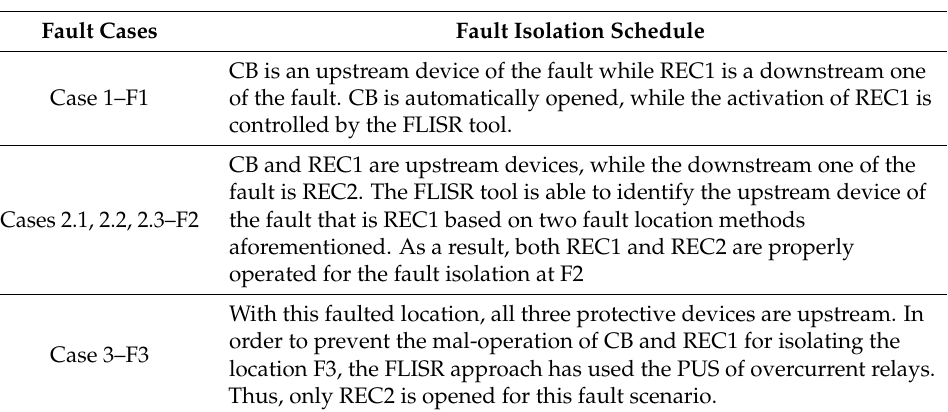
Table 4. Fault isolation scenarios performed by the FLISR